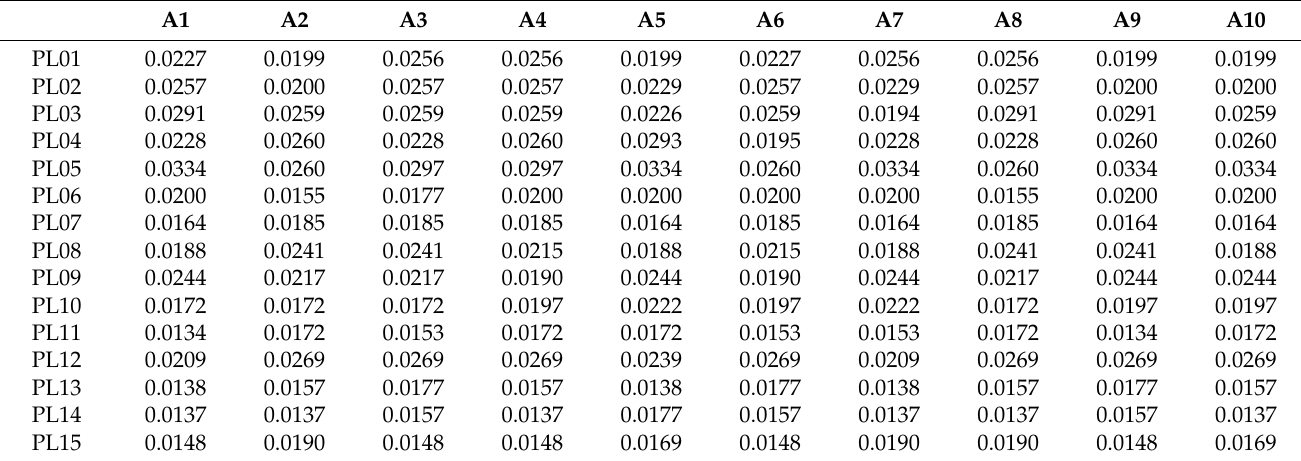
Table 4. Normalized weight matrix.